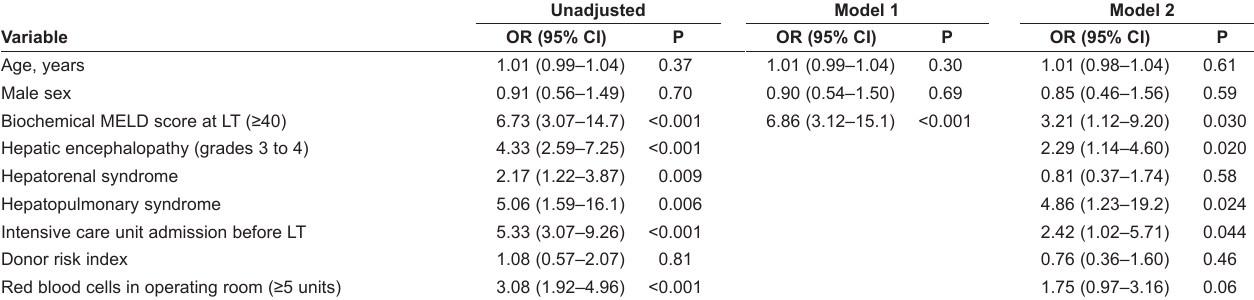
TABLE 3 Logistic regression analysis: variables associated with a length of first intensive care unit stay after liver transplant (LT) ≥10 days